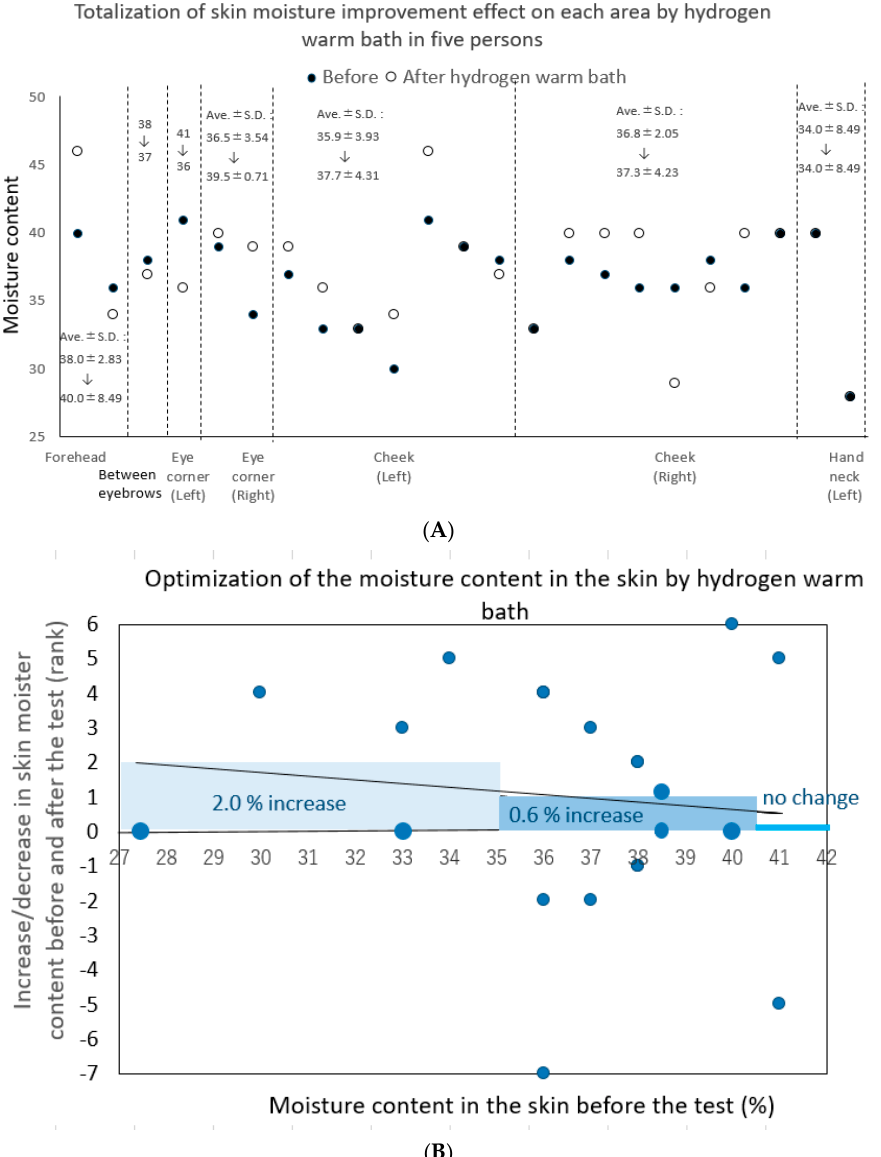
Figure 6. Hydrogen-rich warm-water bath and poultice increased the amount of moisture in dry skin. ( A ): Dot graph indicating change in the rank of the water content with five degrees before and after bathing, as divided by six loci of all subjects. ( B ): Dot graph indicating change in the percentage of the water content for 23 loci of the face and hand. The horizontal axis shows the water content (%) before hydrogen application, while the longitudinal axis shows the change in the water content. The negative correlation was observed between the original water content and change in the water content, with a correlation coefficient: − 0.090.